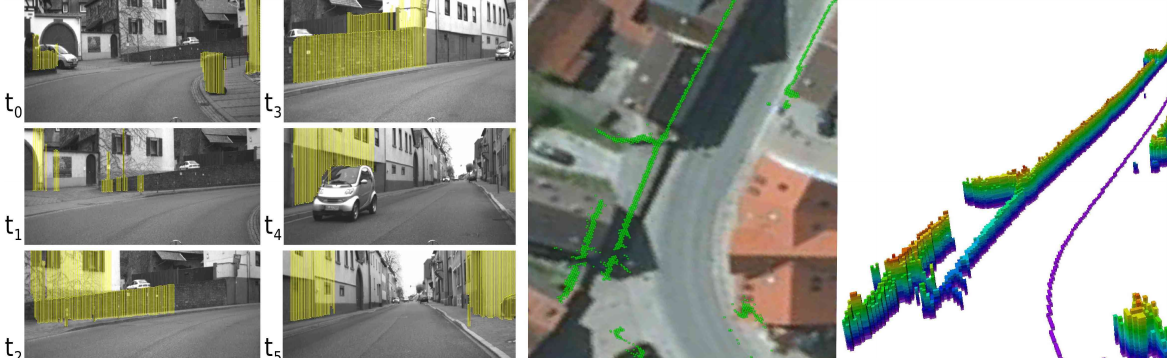
Figure 6: The first detailed example of the 3 . 000 image sequence is shown. The original images with the input Stixels (left), the 2D mapping results overlaid on Google Earth images (center) and the 3D representation (right) using the OctoMap representation are shown. Due to the segmentation of the multi-layered Stixel World into stationary and moving objects, the oncoming vehicle is not taken into account for the mapping approach. Furthermore, walls behind walls are represented. Because of the limited field of view the right building in this scene could not be mapped.